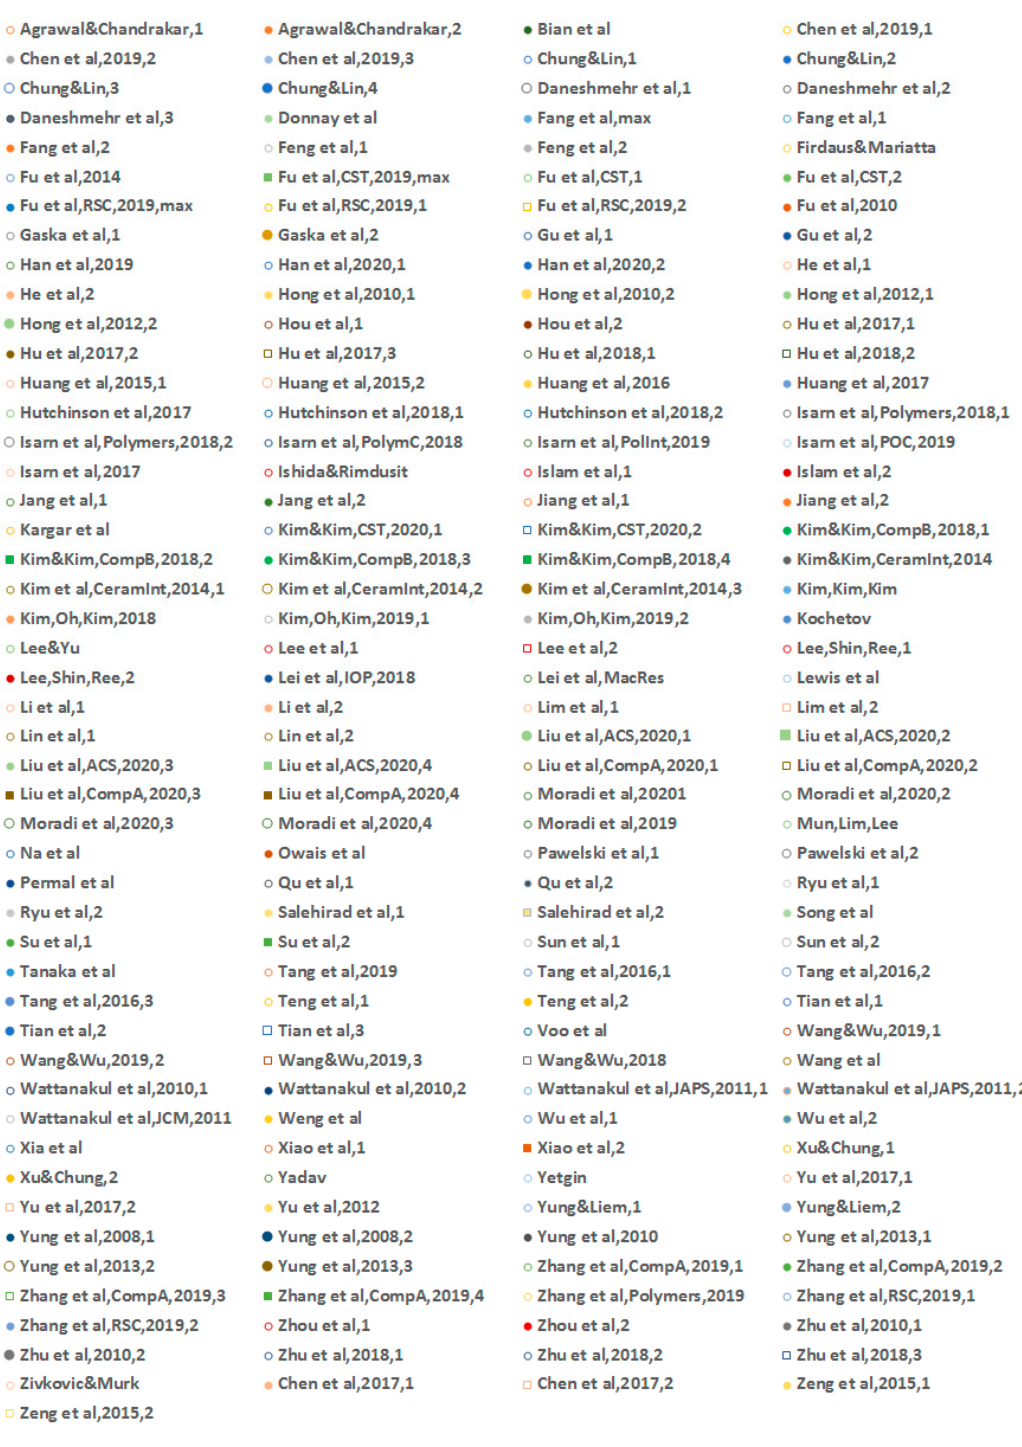
Figure 9. Maximum values of thermal conductivity as a function of BN content for data taken from references [54,57,59–159]. Colour coding for references is given in the legend but can be seen more clearly in Supplementary Material 3. Open circles: untreated particles; filled circles: treated particles. Squares correspond to data from oriented samples. Increasing size of particles within any set of data is represented by increasing size of symbol. Dashed lines are the intermediate and lower trend lines, and are drawn to guide the eye. Some of the data at 20, 30 and 40 wt.% BN have been shifted slightly to lower or higher BN contents to avoid overlapping, for clarity.